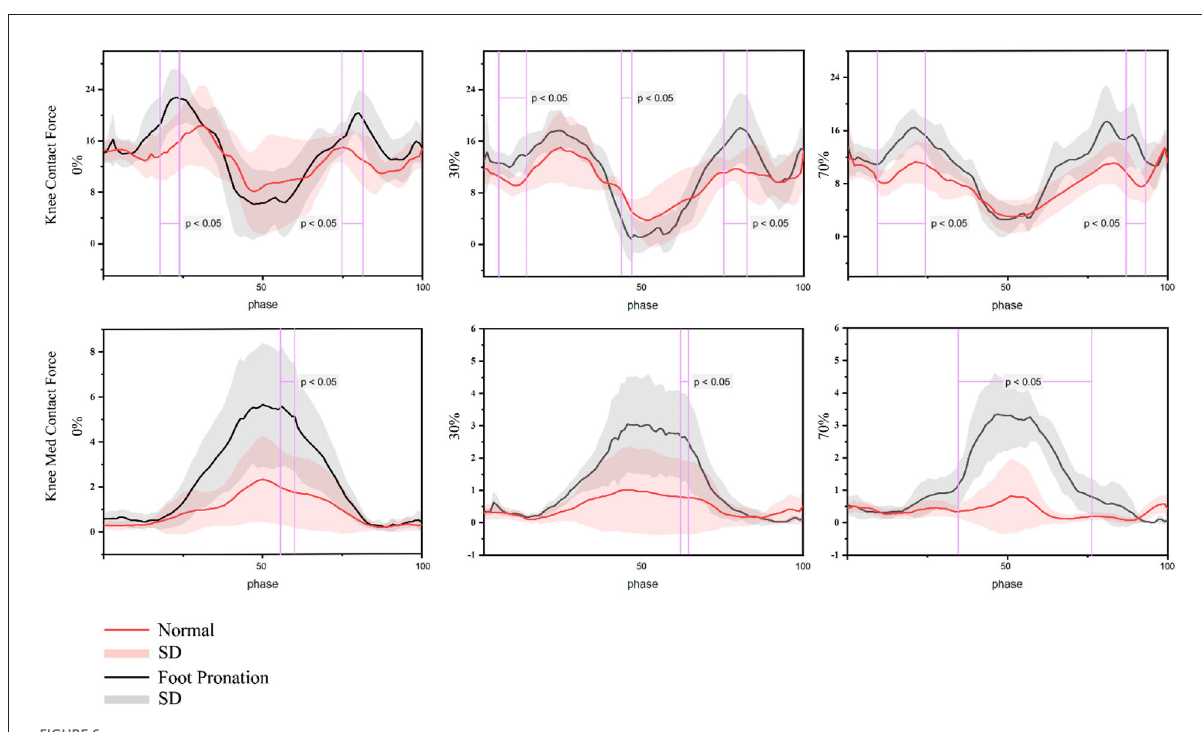
FIGURE6 Contact force of the knee joint of the barbell squat in people with pronation foot and normal foot